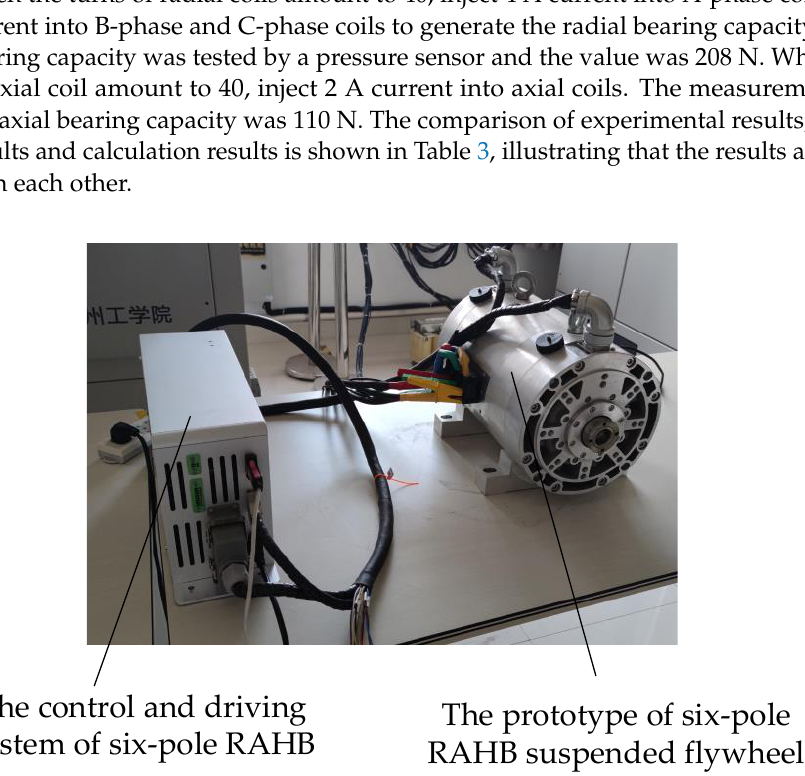
( b ) Figure 8. FE analysis results of axial flux density with maximum axial control current. ( a ) Flux dis- tribution of axial stator. ( b ) Flux density in axial air gaps.